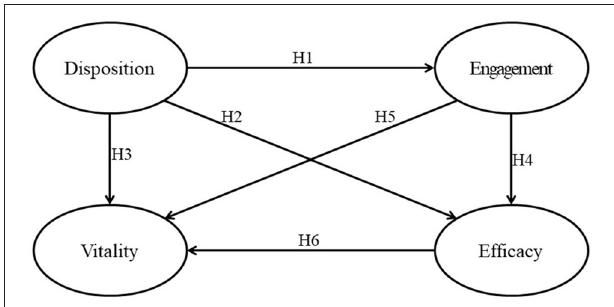
FIGURE 1 | Structural equation model of the design-associated variables of